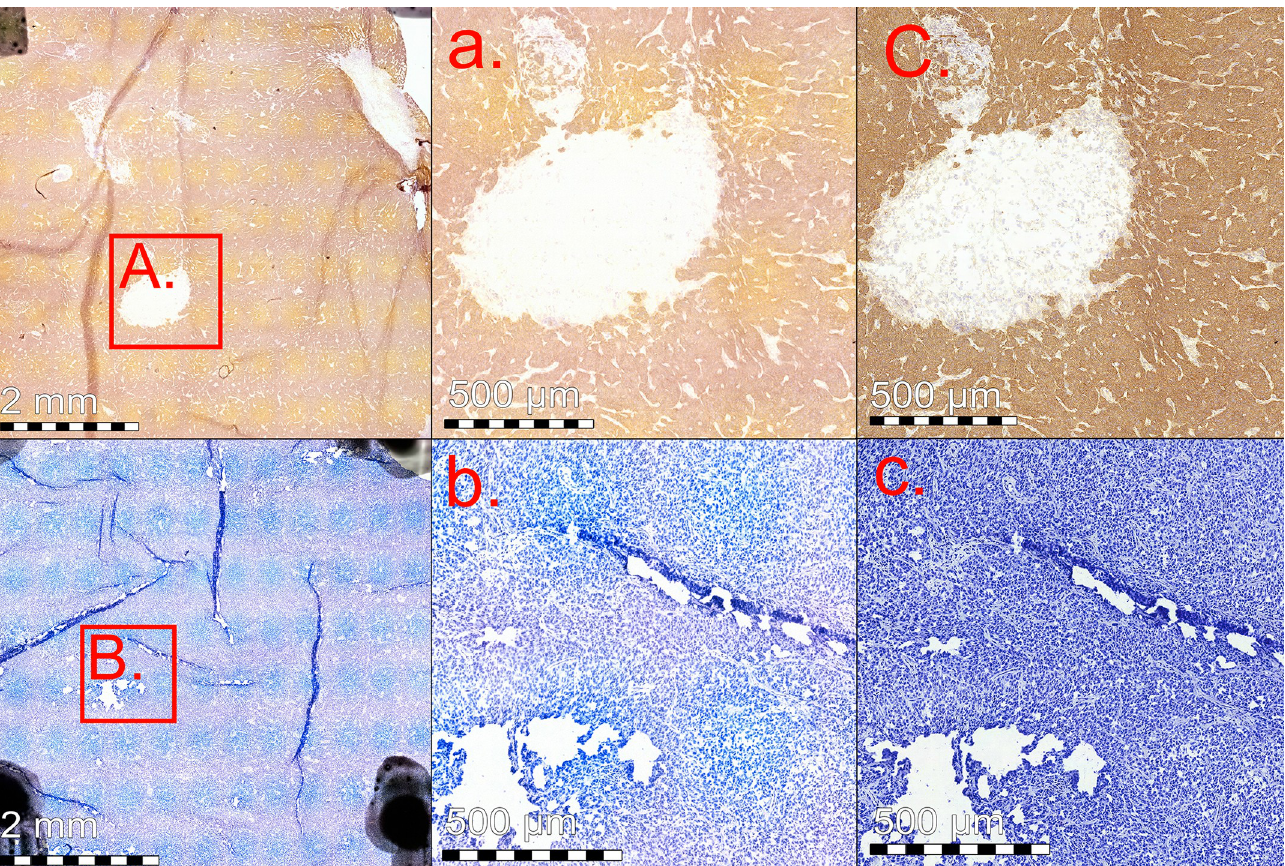
Fig 6. Lymph node frozen section with macrometastasis, stained with both anti-cytokeratin (upper row) and toluidine blue (lower row) staining. Overview of area scanned with miniature microscope (left), red bounding box (A. and B.) showing enlarged area (a. and b.). Reference scanner corresponding regions for comparison purposes shown to the right (C. and